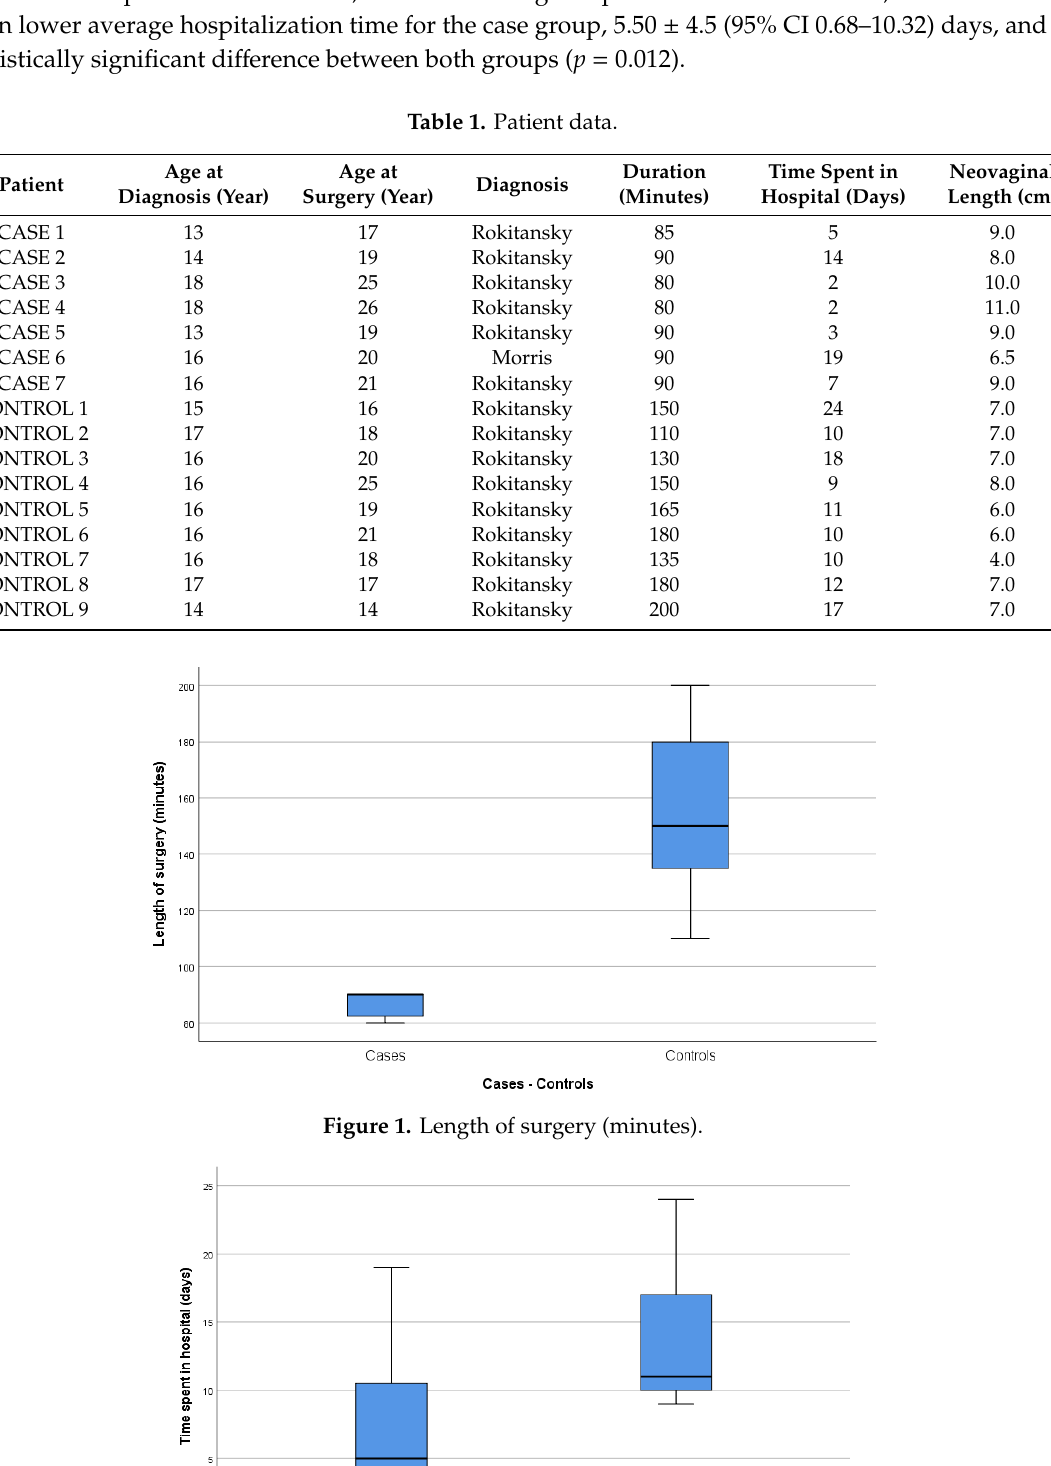
Figure 2. Time spent in the hospital (days).